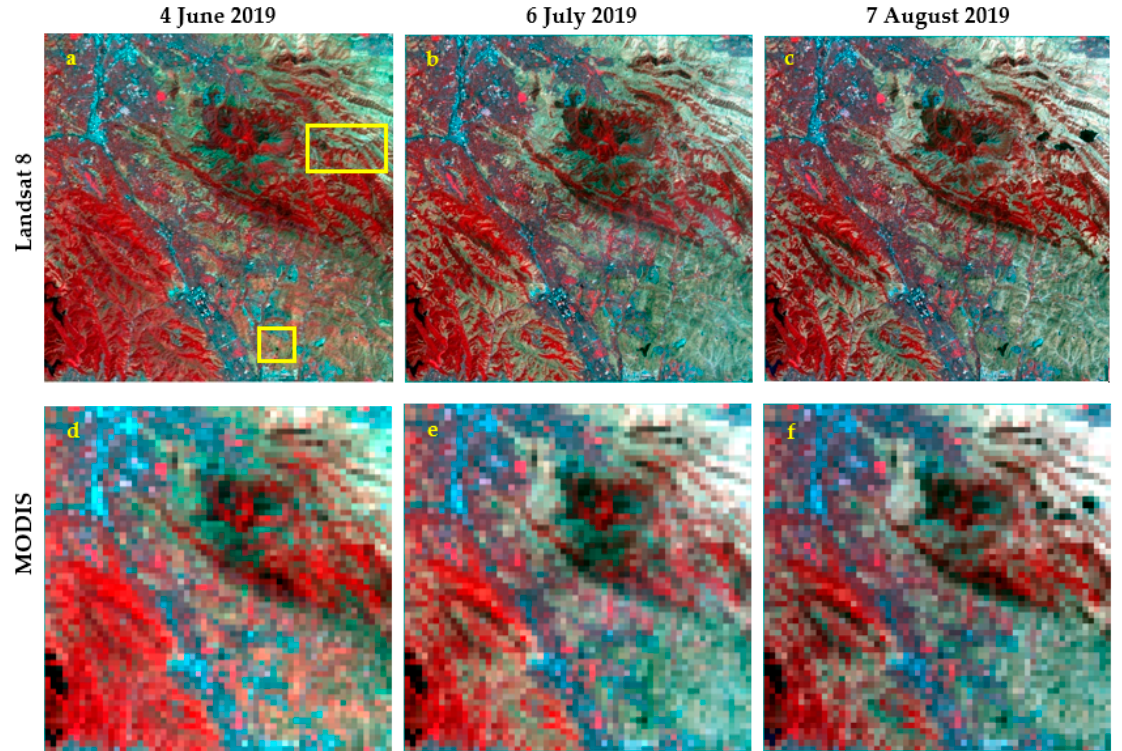
Figure 2. Color composited images (RGB: near-infrared, red, green) of the study area. ( a – c ) are the Landsat 8 images acquired on 4 June, 6 July and 7 August 2019, respectively (960 × 960 pixels with a 30 m resolution), and ( d – f ) are moderate resolution imaging spectroradiometer (MODIS) images (480 m resolution) aggregated from ( a – c ).